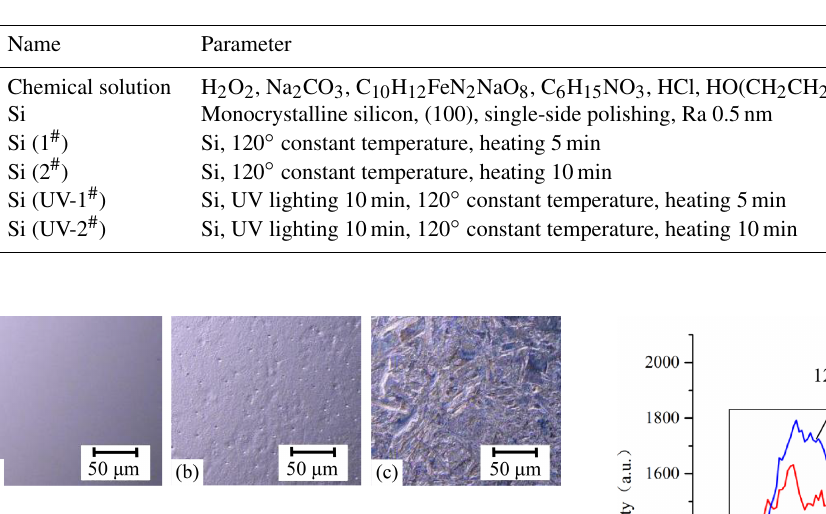
Table 1. The chemical modification strategy and experimental parameters.